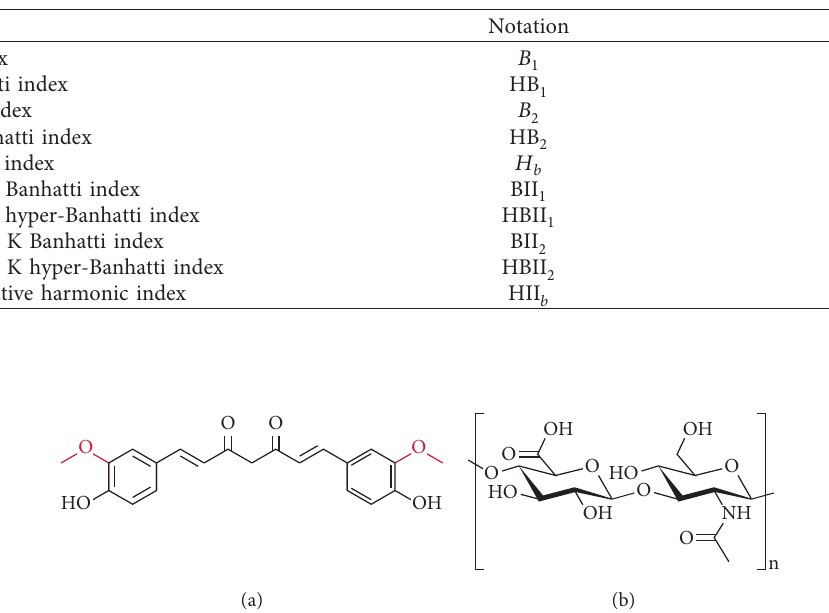
Table 1: K Banhatti indices of a graph G